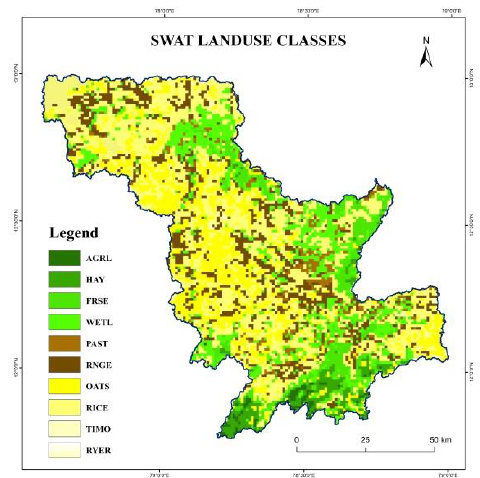
Figure 4. SWAT LU/LC classes